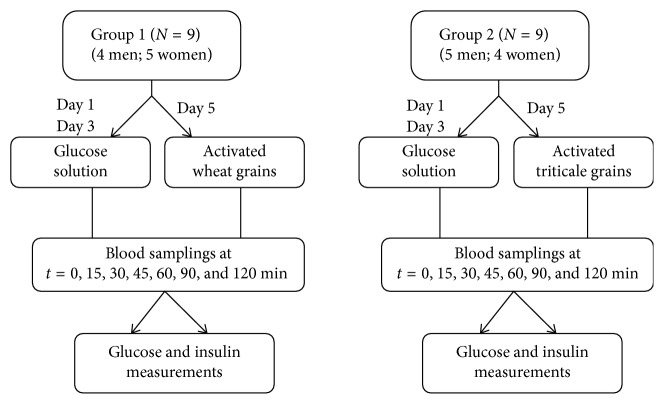
The study design.